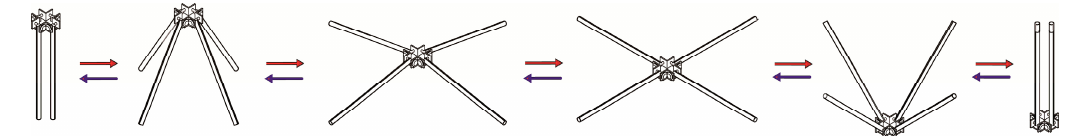
Figure 8. Synchronous and symmetric motion of n 1 = 4 links connected the novel joint with bevel gears.